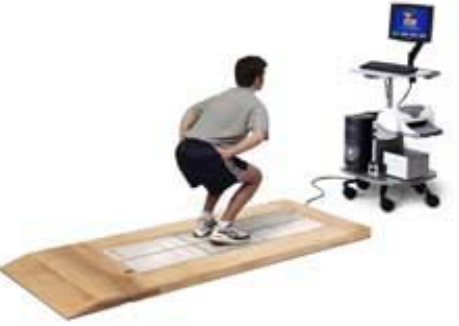
Figure 6. Patient completing a test on a stabilometric